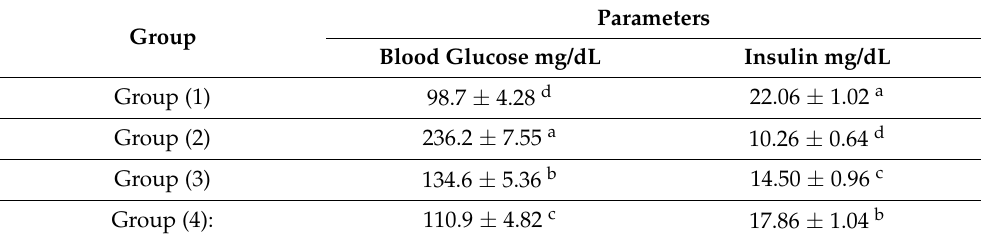
Table 4. Effect of fermented camel milk supplemented with SFP on blood glucose and insulin of rate